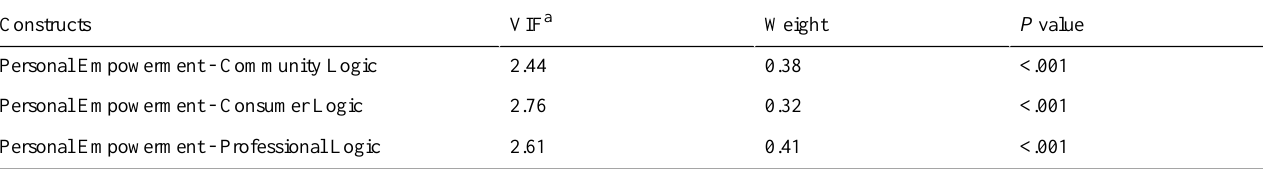
Table 6. Measurement model evaluation for the higher-order formative constructs personal